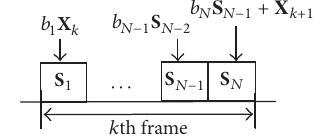
Figure 1: Signal frame format of ORM-DCSK.